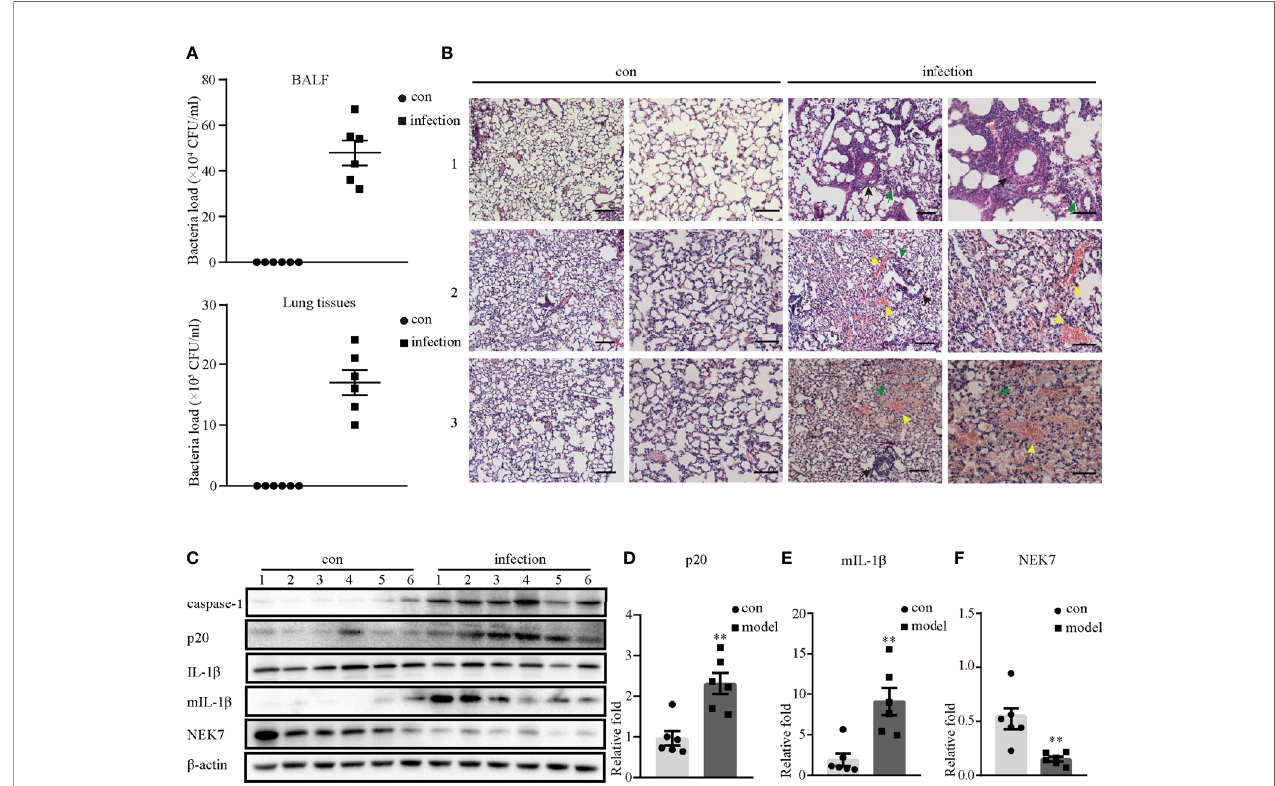
FIGURE 1 | NLRP3 in fl ammasome was activated in S. aureus -induced mouse pneumonia. 6-8 weeks old female mice (C57BL/6) were randomly divided into the control group and the infection group, groups were both challenged with indicate stimulate groups. The infection group mice were challenged with 25 µl of a 10 9 CFU/mL suspension of S. aureus by intranasal administration, while the mice in the control group were given an equal volume of sterile PBS solution. (A) Bacterial load of BALF or lungs were determined in the control group and the infection group by CFU assay. (B) Histological examination for lungs were visualized by H&E stain (×100 magni fi cation, fi rst column and third column; ×200 magni fi cation, second column and forth column). The arrows represent different in fl ammatory pathological changes in the infection group. (Scale bar: 100 µm.) (C) Western blot showing the protein levels of caspase-1, p20, pro-IL-1 b , mIL-1 b and NEK7. (D – F) Densitometry analysis of p20, mIL-1 b and NEK7. Control group n =6, infection group n =6. Data shown are means ± SEMs; ** P < 0.01 vs. control group.